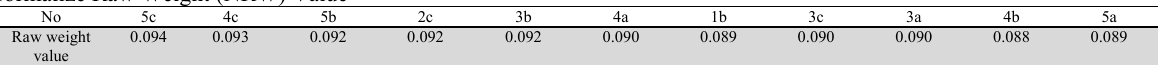
Normalize Raw Weight (NRW) Value